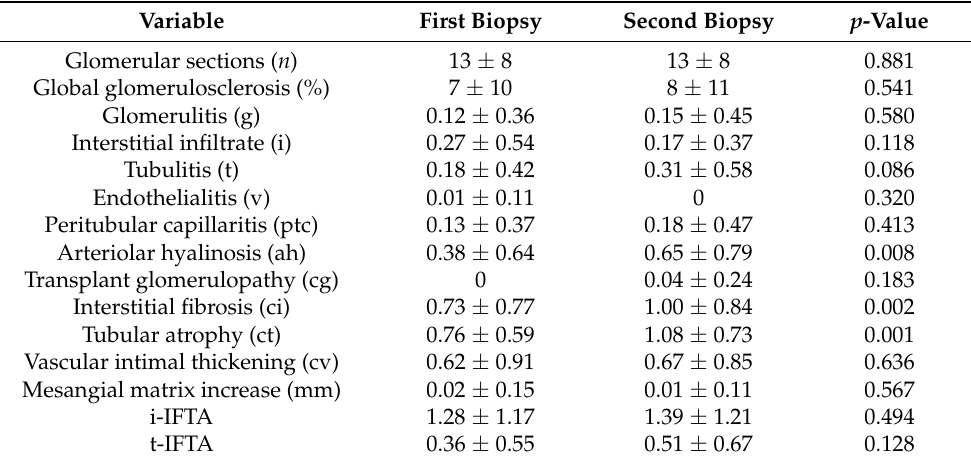
Table 3. Banff scores in the first and second surveillance biopsies ( n = 85).